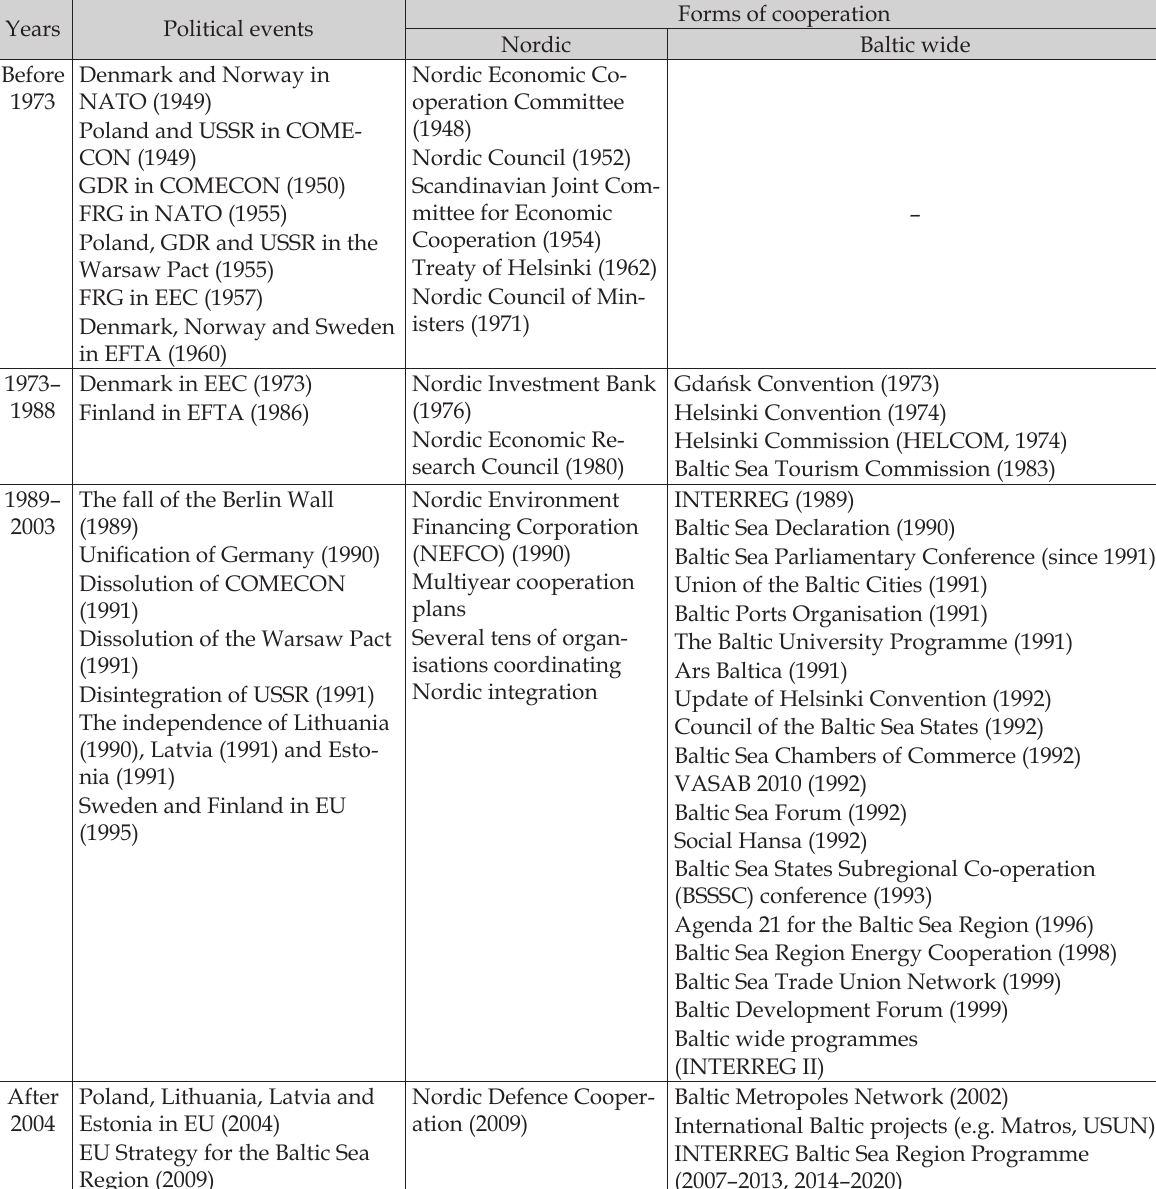
Table 1. The timeline of Baltic regional